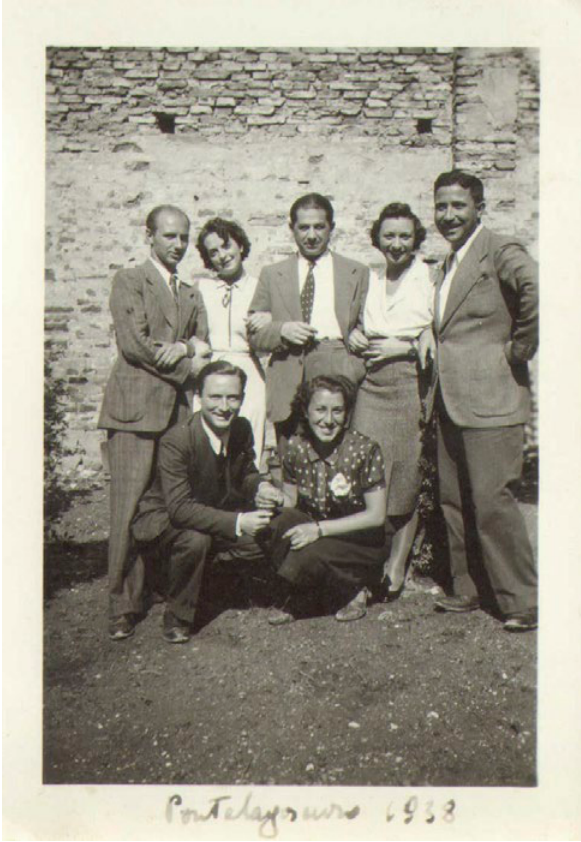
Figure 3. Zvi (in the centre) with collaborators at Pontelagoscuro, just before the departure from Italy; (from the private collection of the Jolles-Bainbridge family, now in the Fondo Jolles at Florence University Museum of Natural History).